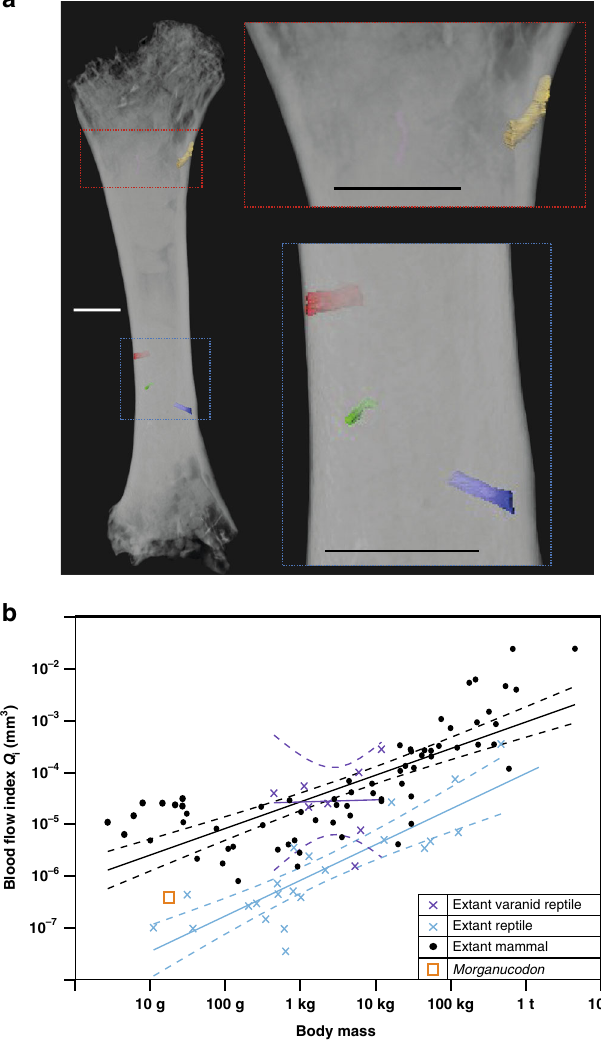
Fig. 7 Femoral foramina and estimates of relative femoral blood fl ow for Morganucodon . a 3D reconstruction of Morganucodon femur using µ CT (specimen UMZC EoPC 19_6, voxel size of 4 μ m), with all identi fi able foramina segmented and highlighted (red, green, gold and blue). b Log 10 biplot of mean body mass (g) against estimated blood fl ow index ( Q i ; mm 3 ) for extant non-avian reptiles ( n = 22), extant varanid reptiles ( n = 8), extant mammals ( n = 69) and Morganucodon . GLS regression lines in b are shown for extant mammals (black), extant non-varanid reptiles (blue) and extant varanids (purple), with 95% con fi dence intervals represented by dashed lines. Scale bars in a represent 1 mm. Source data are provided as a Source data fi